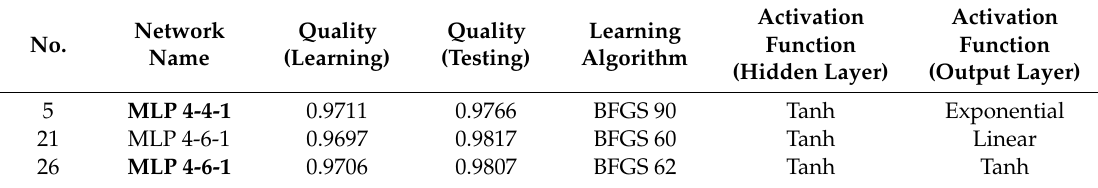
Table 6. Selected neural networks based on four di ff erent variables (generated in Statistica).